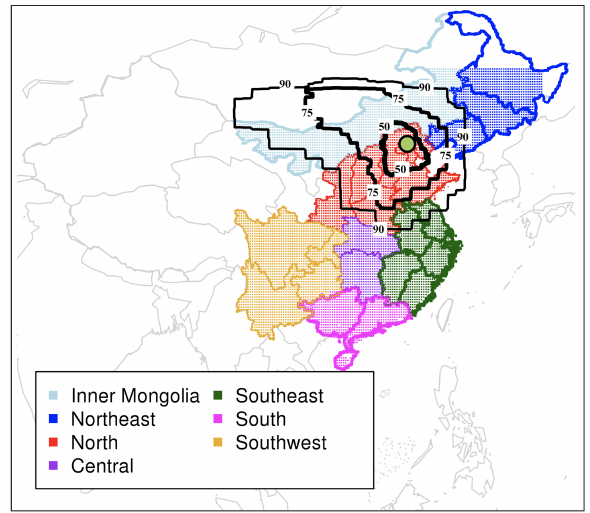
Figure 11. STILT influences and major administrative regions of China in the study domain. Administrative regions are categorized according to the convention in Piao et al. (2009). Stippling repre- sents the location of 0 . 25 ◦ × 0 . 25 ◦ VPRM-CHINA and ZHAO grid cell centers within the regions. Black contour lines display the 50th, 75th, and 90th percentiles of mean annual STILT footprints (2005– 2009) to highlight regions with the greatest influence on the Miyun receptor (solid green circle). Note that two of the regions (Inner Mongolia and Northeast China) are mostly, but not completely, en- compassed by our study domain. The solid green circle represents the location of the Miyun measurement